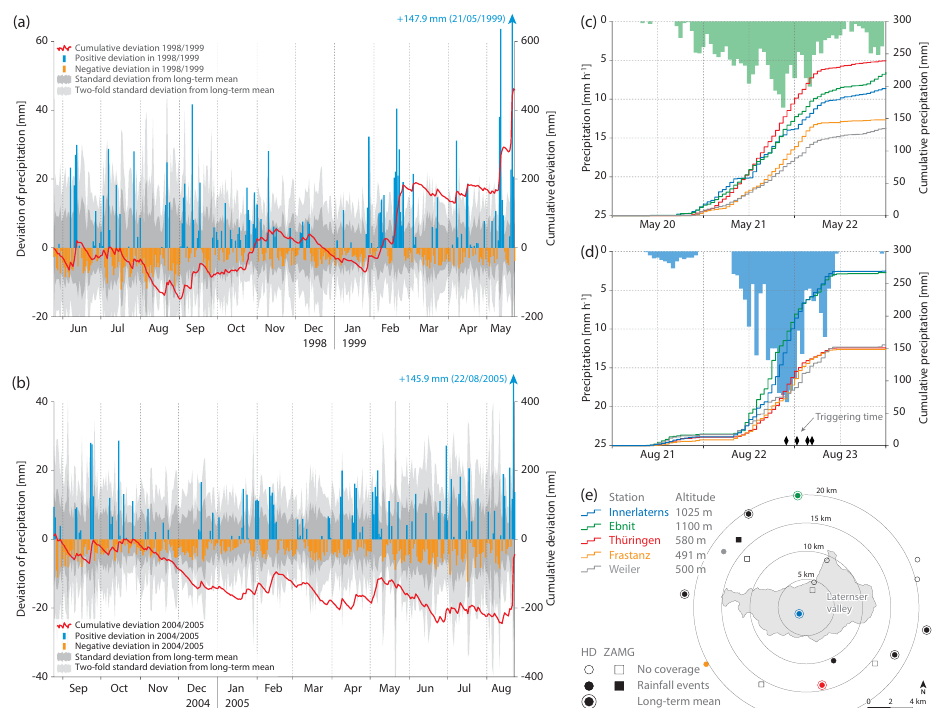
Figure 3. Landslide-triggering rainfall events in the Laternser valley on 21–22 May 1999 (a, c) and 22–23 August 2005 (b, d) . The map (e) shows the meteorological stations considered. Regional daily mean (07:00–07:00) and cumulative deviation of precipitation from the long- term mean (1981–2010) are shown for the period of 1 year before the rainfall events (a, b) . Cumulative precipitation for 3 days covering the landslide-triggering rainfall events are shown for meteorological stations within and surrounding the Laternser valley (c, d) . Hourly precipitation sums are shown for Ebnit station in May 1999 (c) , because at Innerlaterns station missing values are present in the respective hourly time series. Estimated triggering times of four shallow landslides were derived from protocols by the voluntary fire brigade.